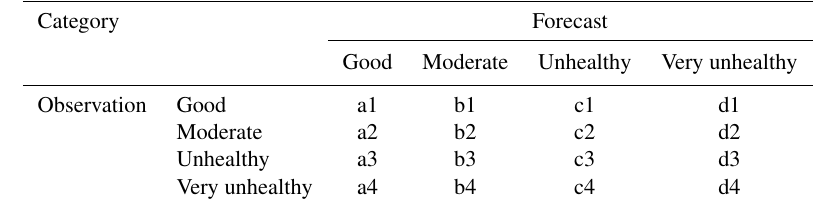
Table 3. Categorical forecasts for different air pollution events.